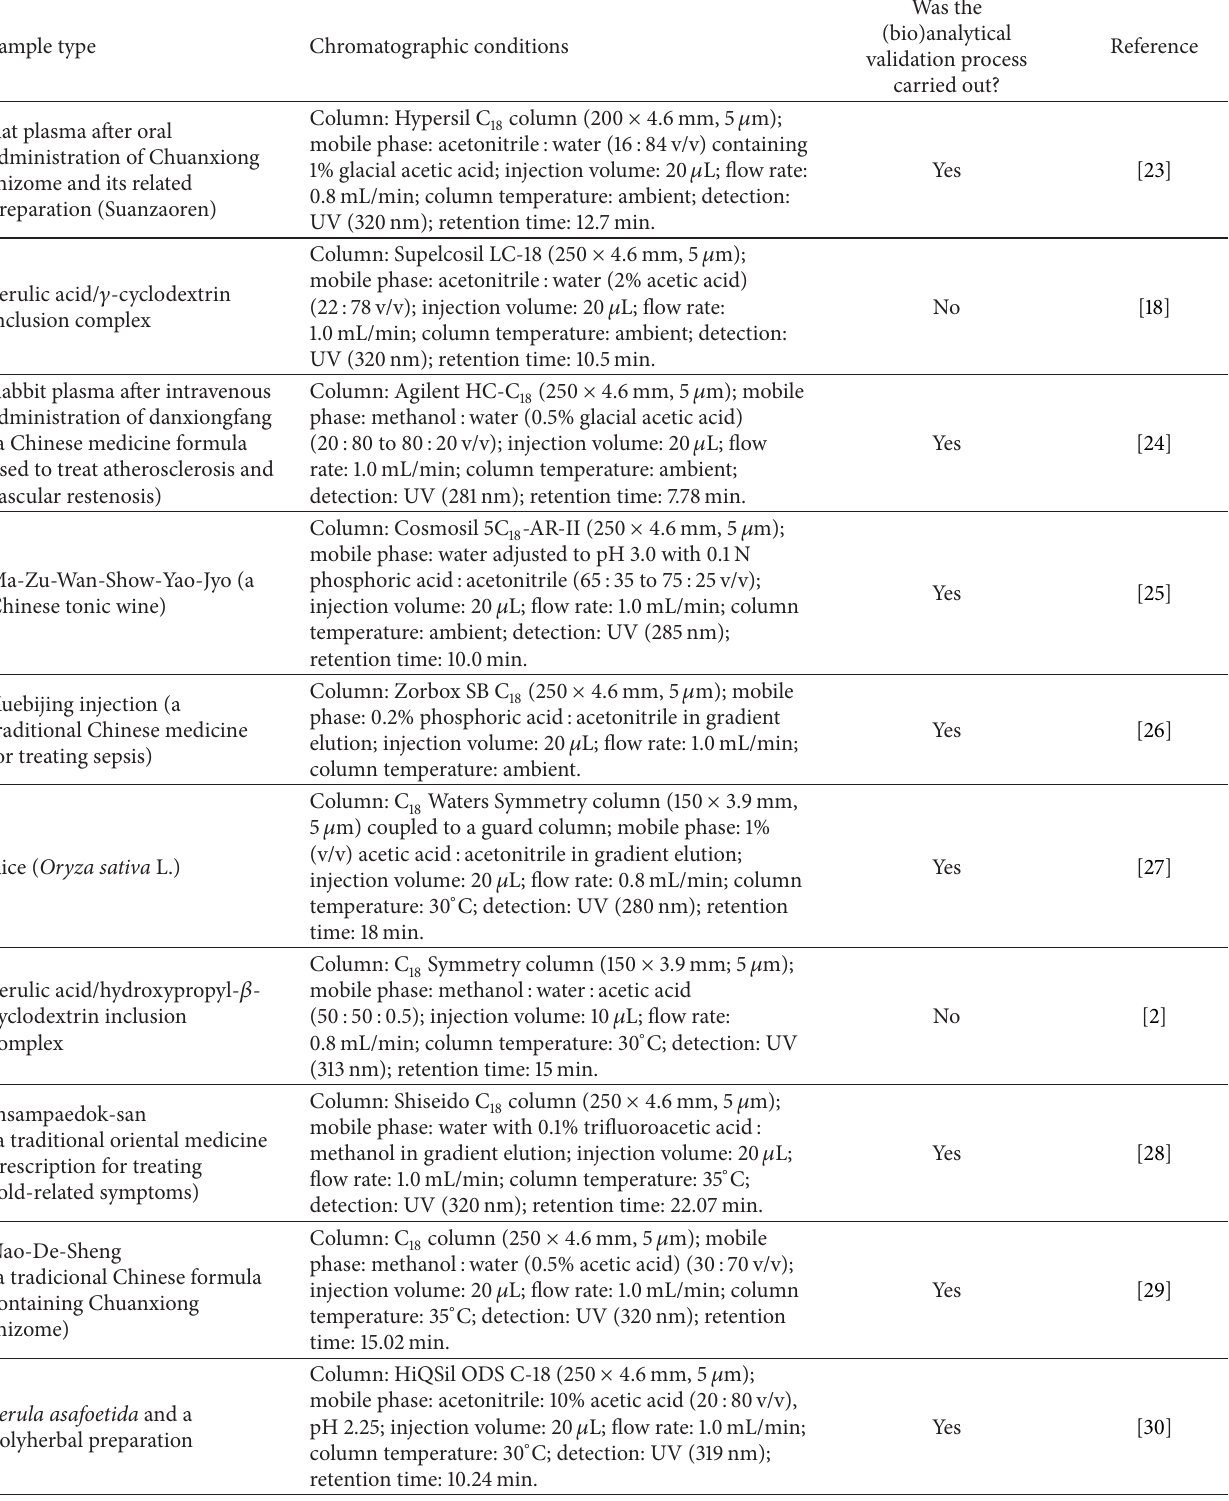
Table 1: Previous papers that report HPLC methods for isolation and quantification of